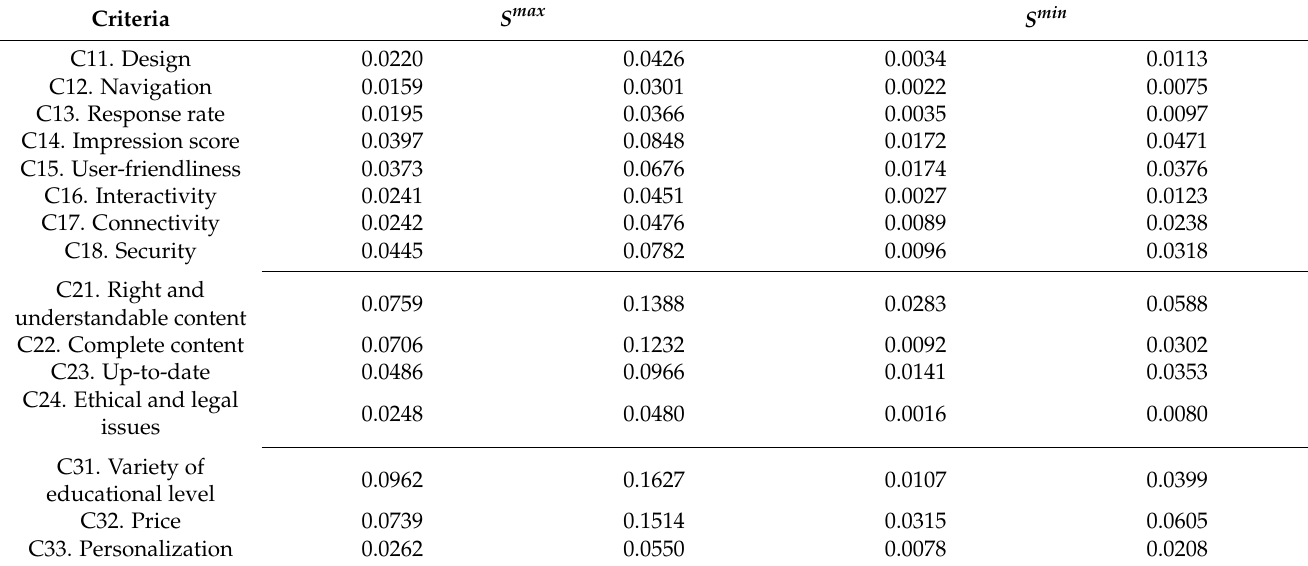
Table 10. The values of the grey positive and negative ideal solutions from the G-TOPSIS model.